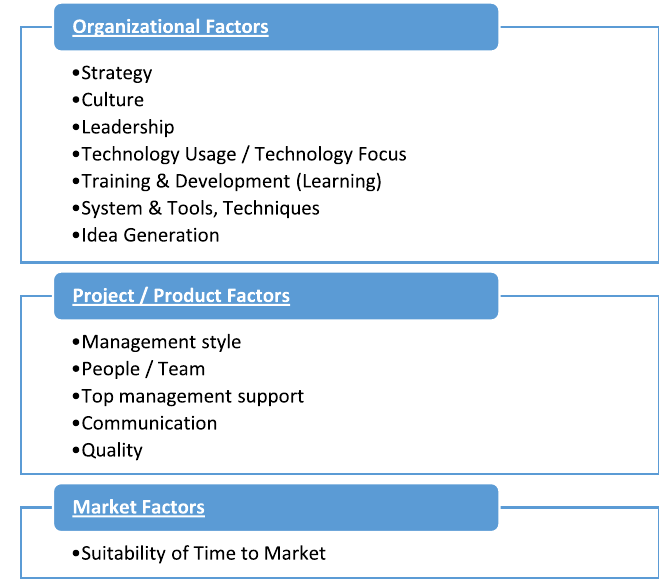
Fig. 10 Proposed innovation management framework